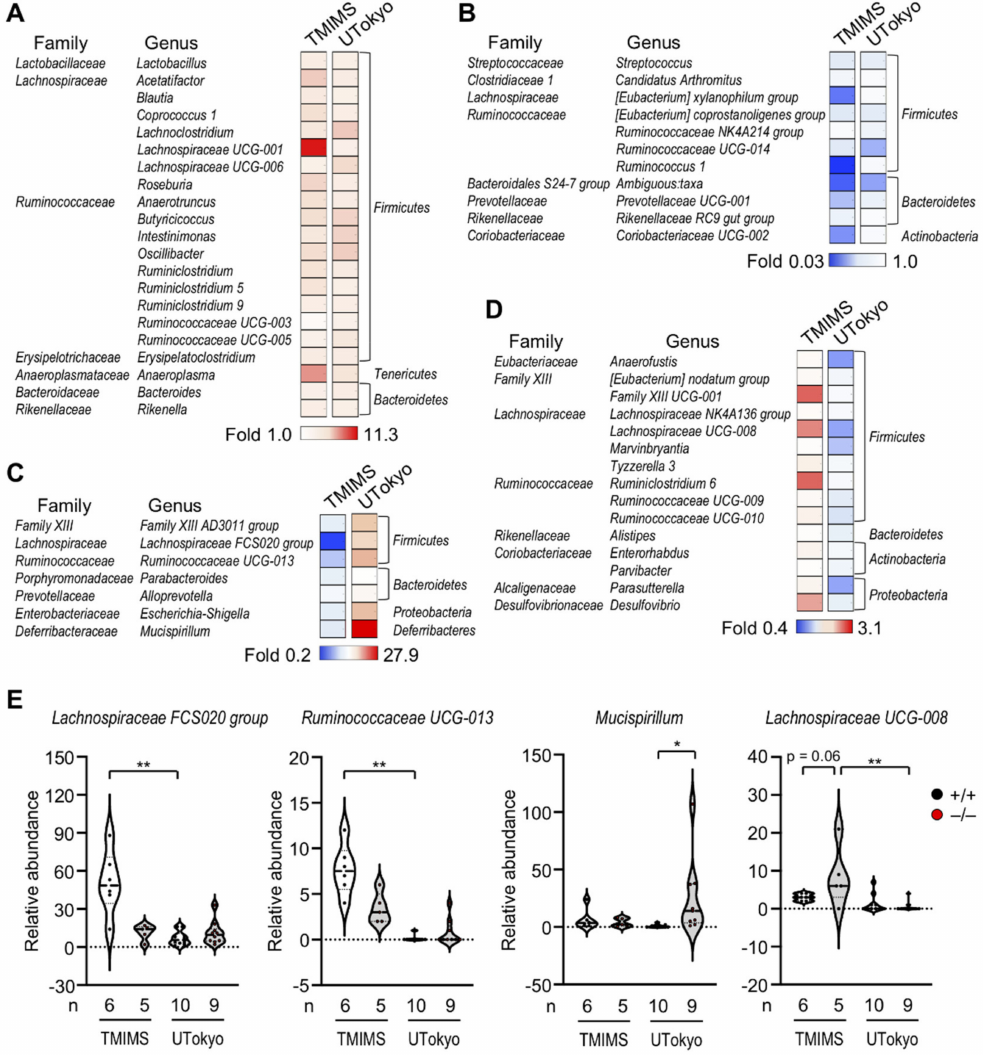
Figure 4. The effects of sPLA 2 -IIA deficiency on the gut microbiota in the TMIMS and